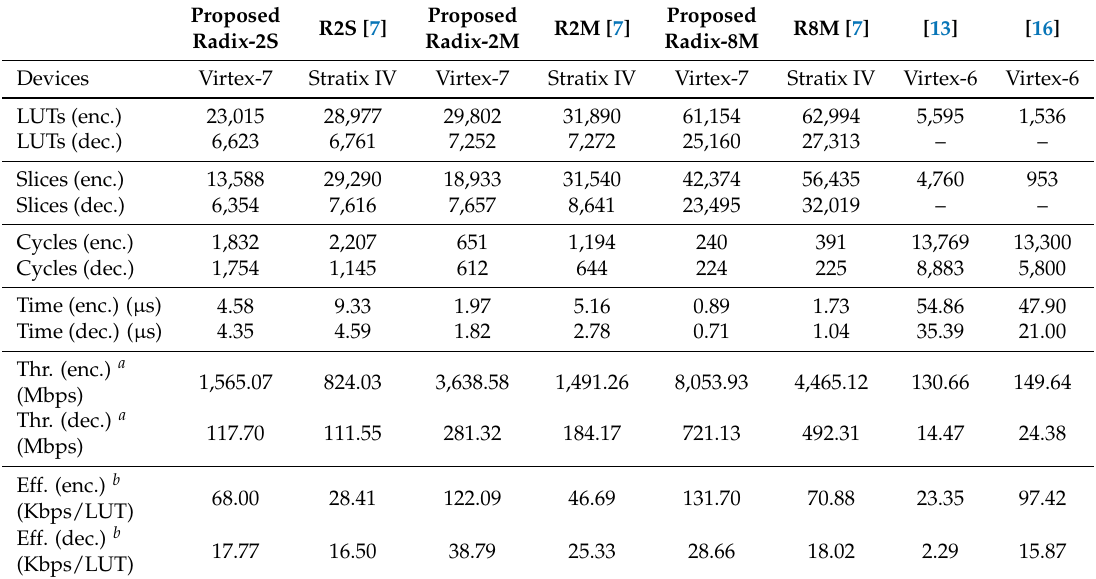
Table 1. Implementation results and performance comparison of the proposed ring-learning with errors (LWE) cryptoprocessors.